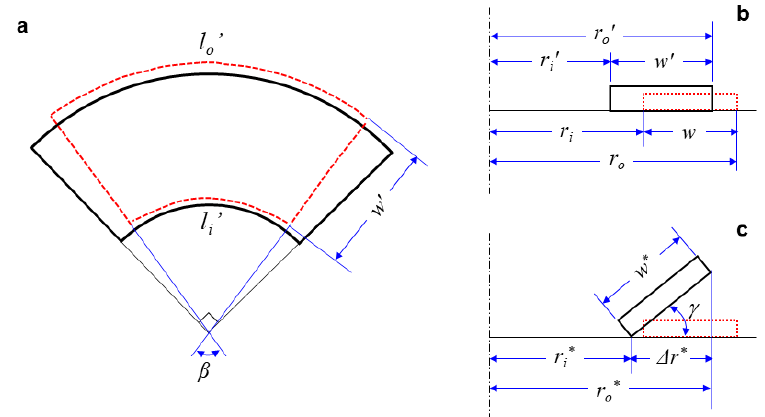
Figure 3. Schematic descriptions of the thermal shape transformations for ( a ) partial annulus (top view), ( b ) partial annulus (side view), and ( c ) full annulus (sectional view).